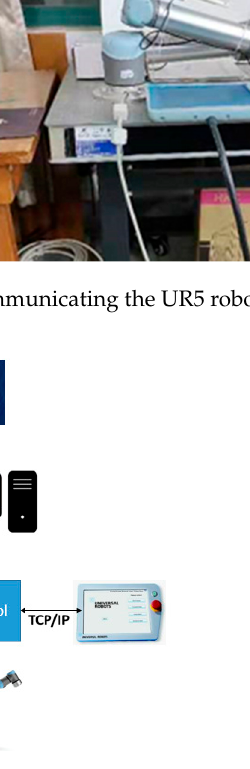
Figure 2. The overall communication model to control UR5.